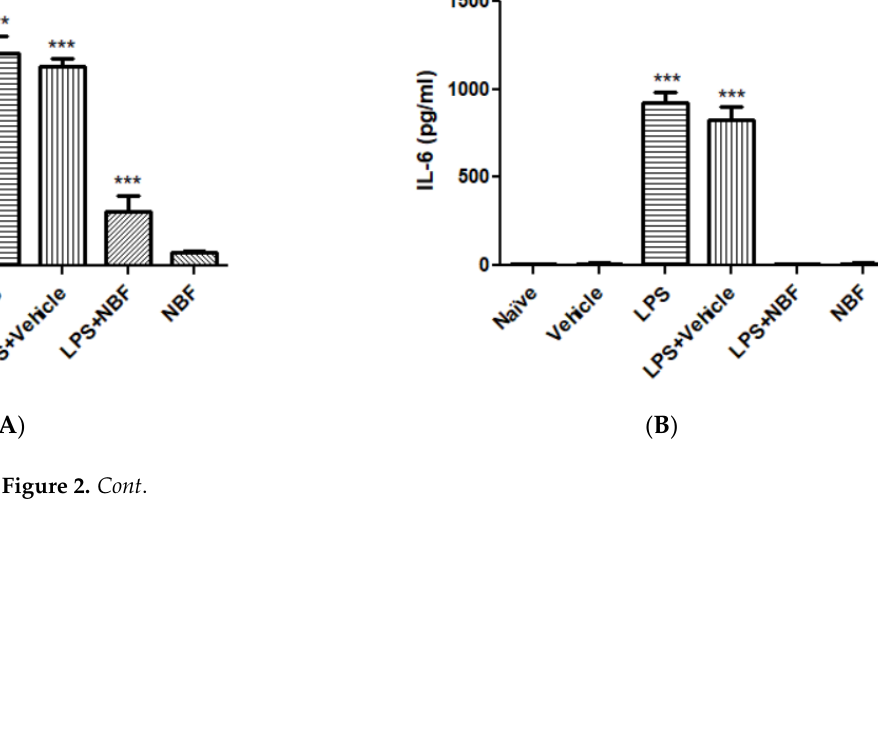
( C ) Figure 2. NBF downregulates the release of pro-inflammatory cytokines induced by LPS in RAW264.7 macrophages. RAW 264.7 macrophages were exposed to 20 ng/mL LPS and simultaneously with the NBF, 20 µg/mL. IL-1 β ( A ), IL-6 ( B ), and TNF- α ( C ) levels were measured using ELISA. The results are presented as the mean ± SD, ( n = 4 in each group). ANOVA followed by Bonferroni’s post hoc test was performed. *** p < 0.001 compared to all other groups. 3.3. Chemokine The effect of NBF on CCL5 (RANTES) release was measured, as a part of the pro- inflammatory response using ELISA. Naïve and vehicle did not affect CCL5 release, while CCL5 levels were significantly increased in the LPS and LPS + vehicle groups as compared to vehicle. The release of CCL5 was completely inhibited following exposure of the cells to LPS + NBF. NBF alone did not affect CCL5 levels (Figure 3).